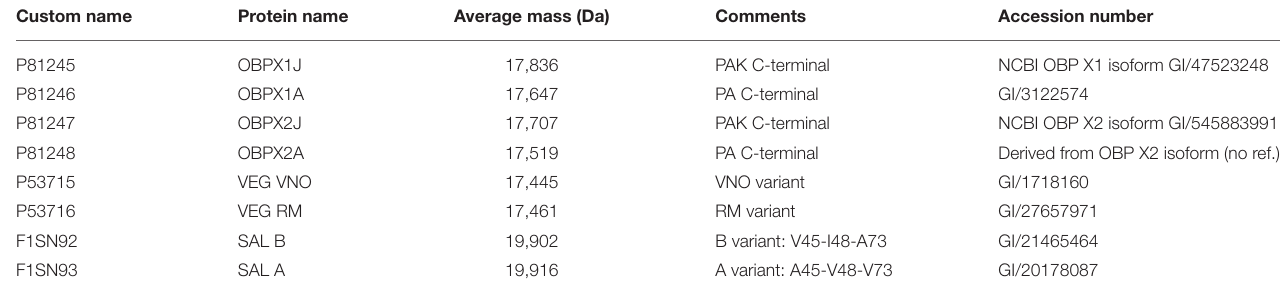
TABLE 1 | Custom-made OBP database used for characterization of 2-DE spots from M14 sample.